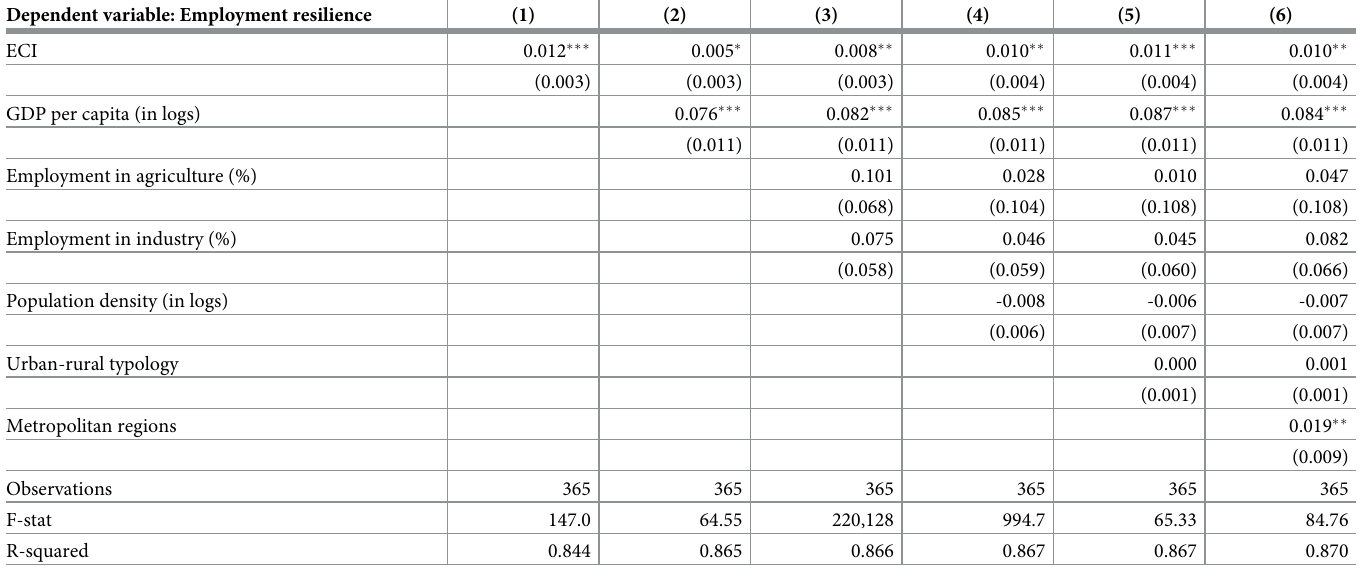
Table 3. Regression